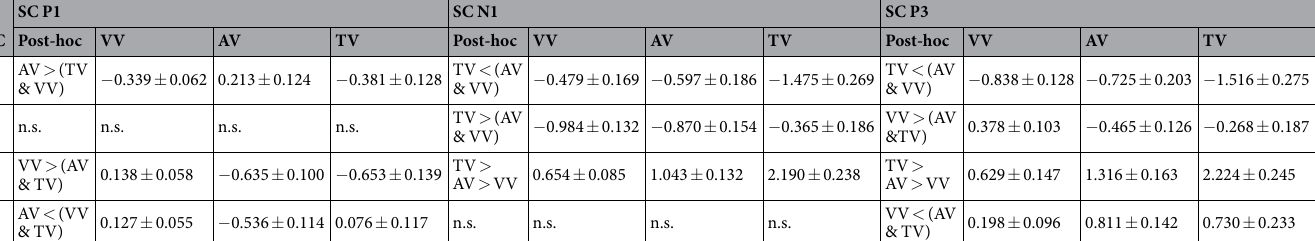
Table 2. Relevant independent components. Significant results obtained by means of post-hoc t-tests and IC values averaged over the time windows which were used for ERP quantification (see Table 1). Values are only reported for analyses of ICs yielding significant task version effects (refer Table 1). VV = visual-visual task version, AV = audio-visual task version, TV = tactile-visual task version. In the Post-hoc columns, significant differences are indicated by the “ > ” and “ < ” signs while non-significant differences are indicated by the “&” sign and grouping the respective task versions within brackets.